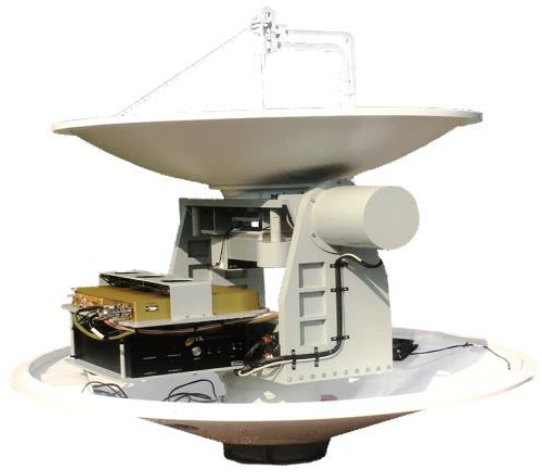
Figure 11. The Ku-band entomology radar used in the data collecting.